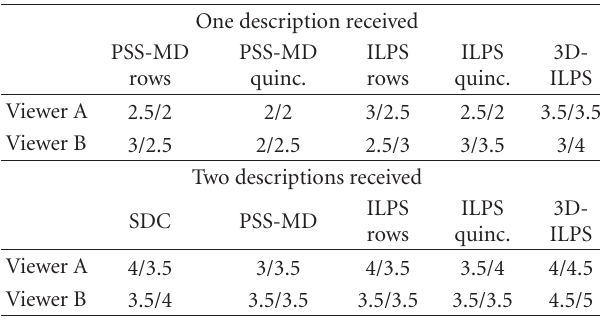
Table 6: Mean Opinion Score with 10% packet loss, Break- dance/Ballet, color